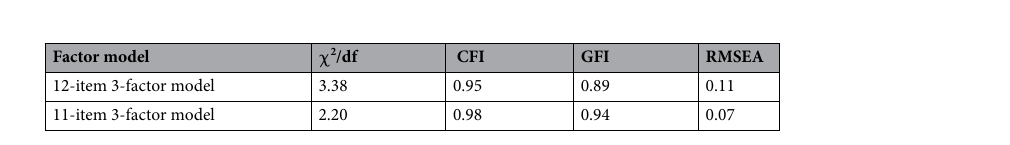
Table 3. Fit statistics for the Chinese version of the HHI (n = 206). χ 2 /df, Chi-Square Mean/Degree of Freedom; CFI, Comparative Fit Index; GFI, Goodness of Fit Index; RMSEA, Root Mean Square Error of Approximation. Acceptable overall fit of each model was evaluated using the following indices: χ 2 /df: 3.00 or lower, CFI: 0.9 or higher, GFI: 0.9 or higher, RMSEA: 0.08 or less.